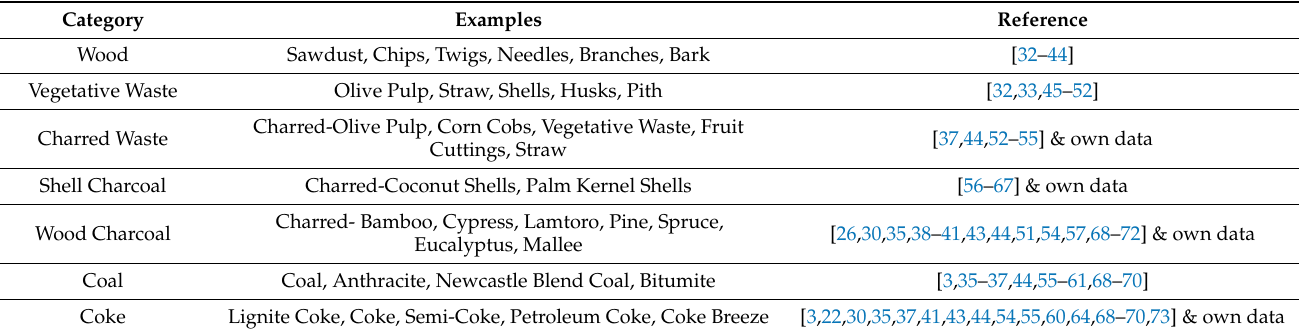
Table 3. Examples of reducing agents or feedstocks used by authors cited in this study and own